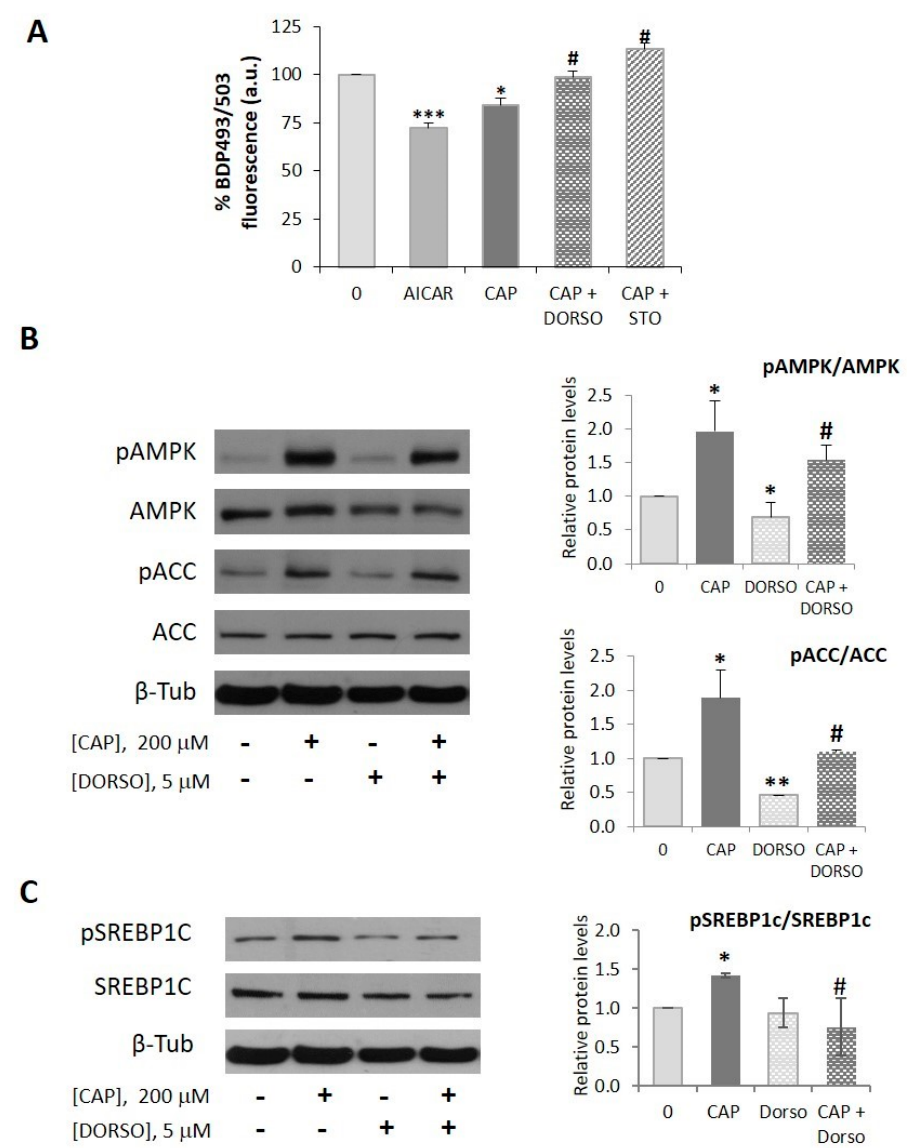
Figure 2. AMPK is involved in the capsaicin-induced reduction of neutral lipid content in HepG2 cells. HepG2 cells were cultured in EMEM medium without serum for 24 h. ( A ) Capsaicin reduces neutral lipid content through CaMKKII/AMPK activation. Cells were pretreated with vehicle, 5 µ M dorsomorphin (DORSO) or 10 µ M STO-609 (STO) for 30 min and then treated with or without 1 µ M AICAR or 200 µ M capsaicin (CAP) for 24 h. Intracellular neutral lipids were stained with bodipy 493/503 (BDP 493/503) for 30 min and fluorescence was measured by flow cytometry to quantify neutral lipid content. The fluorescence intensity of untreated cells (0) was used as the control and the rest of values were expressed as % of the control value. Results are the mean±SEM of four experiments. Statistical significance was determined by one-way ANOVA and Tukey’s multiple comparisons test. ( B , C ) Capsaicin activates AMPK. Cells were pretreated with vehicle or 5 µ M DORSO, and then treated with or without 200 µ M CAP for 1 h. The levels of pAMPK, pACC, pSREBP and their corresponding not phosphorylated forms were determined by immunoblotting. β -tubulin was used as a loading control. The densitometric analysis of the bands is shown on the right. Data are the mean ± SEM of four experiments. Statistical significance was determined by two-way ANOVA and Dunnett’s multiple comparisons test. Comparisons were vs untreated cells (* p < 0.05, ** p < 0.01, *** p < 0.005) or capsaicin treated cells (# p <